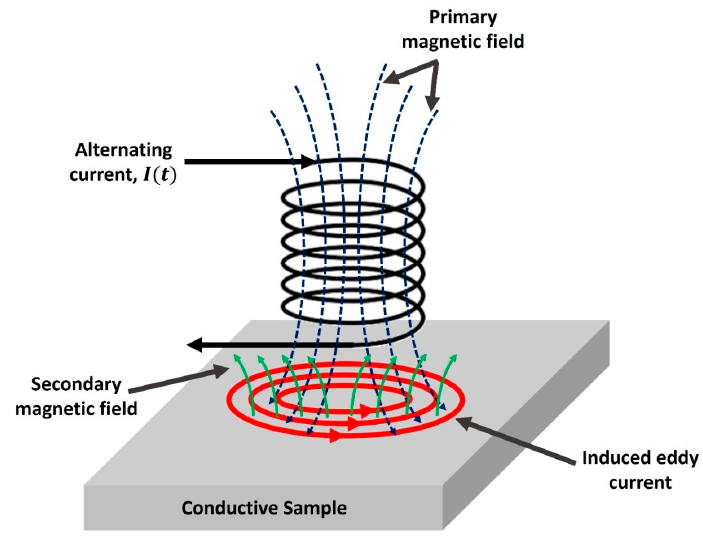
Figure 1. Eddy current working principle for inspecting a conductive sample.